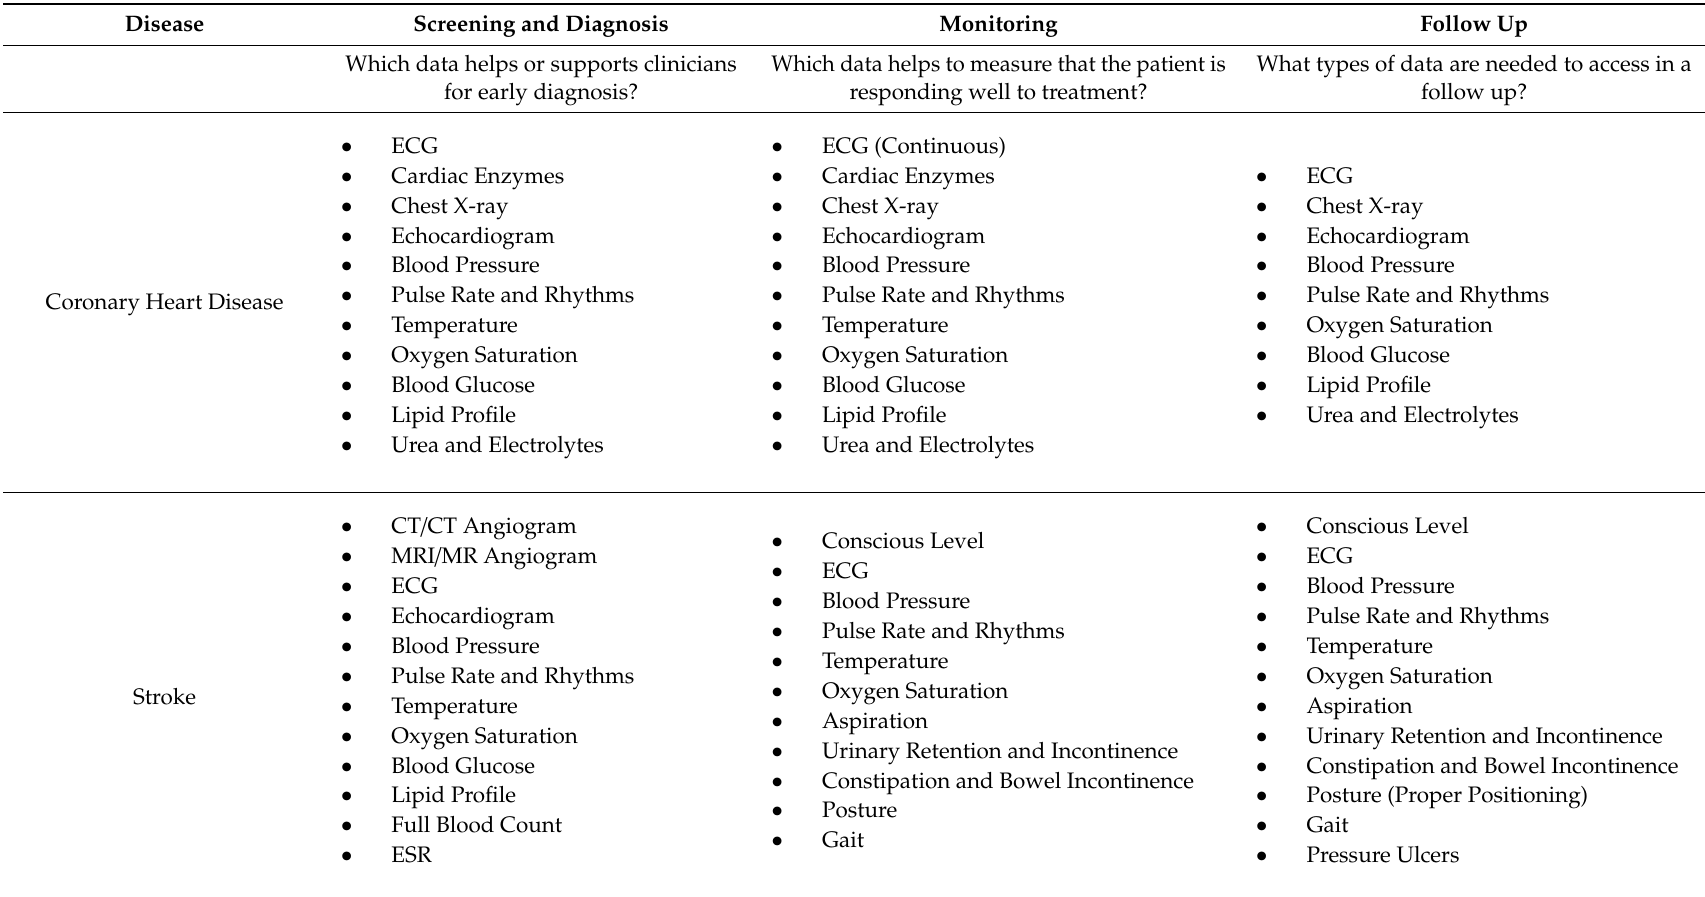
Table A1. The common diseases among the elderly population and the required data in each stage of clinical